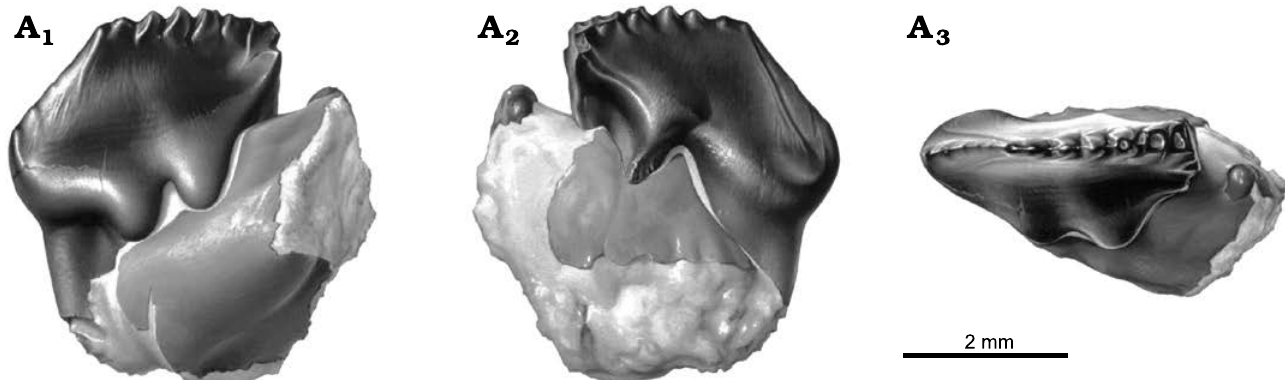
Fig. 1. Reconstruction of left p4 in dentary fragment, NMV P216655, holotype of the cimolodontan multituberculate Corrie baatar marywaltersae Rich, Vickers-Rich, Flannery, Kear, Cantrill, Koma ro wer, Kool, Pickering, Trusler, Mor ton, van Klaveren, and Fitzgerald, 2009, Flat Rocks locality, Eumeralla Formation, Barremian, Lower Creta ceous of Victoria, Australia, in buccal (A 1 ), lingual (A 2 ), and occlusal (A 3 ) views. Artwork by Peter